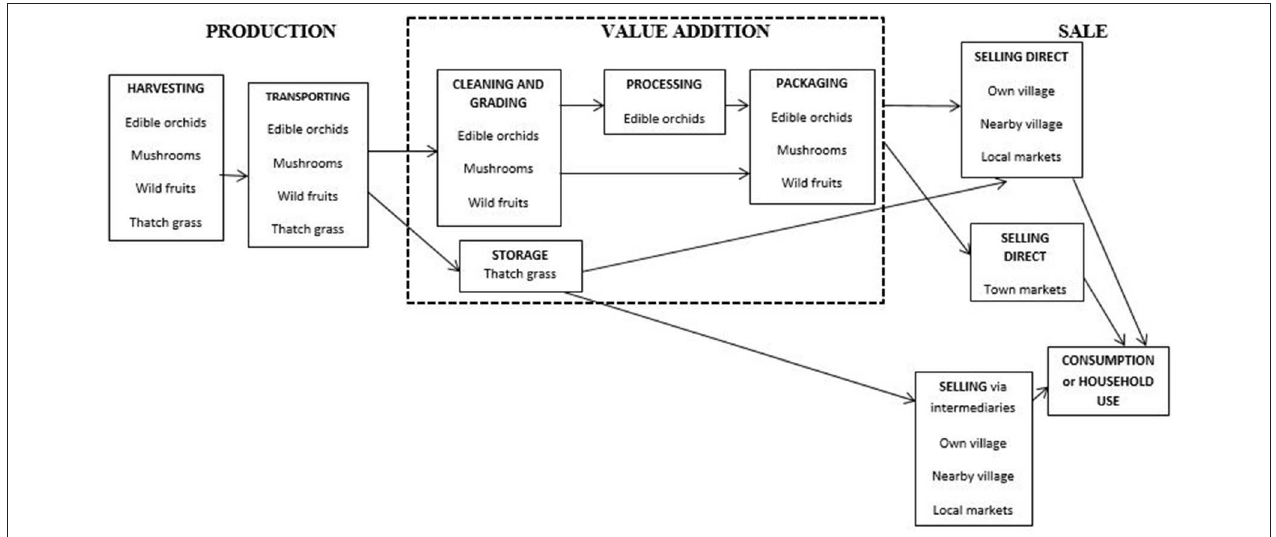
FIGURE 1 | NTFP value chains for mushrooms, edible orchids, wild fruits, and thatch grass.